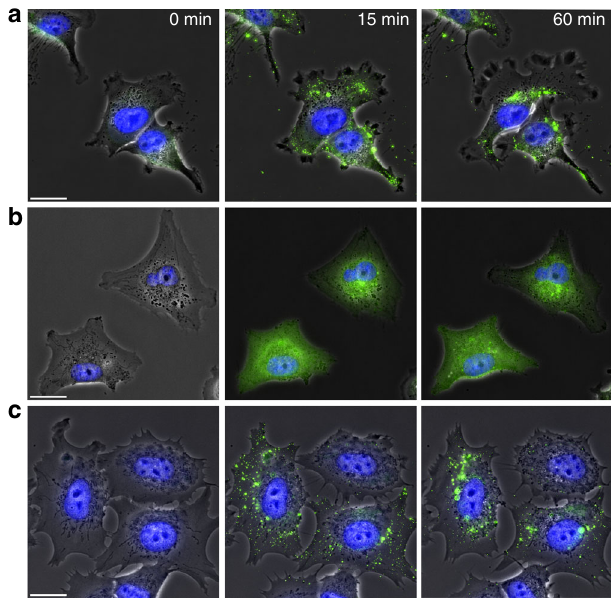
Fig. 4 Dynamics of NP internalization. Extracts of live fl uorescence microscopy images of a and b MDA-MB-231, and c MCF-7 cells exposed to: a and c ANANAS-Atto488-cetux10 (15 µ g/mL, Atto488 = 1.6 × 10 − 7 M) or b cetux-Atto488 (15.1 μ g/mL, Atto4888 1.4 × 10 − 7 M) for 10 min at 37 °C in a fl ow chamber, and then subjected to washing in order to remove unbound nanoparticles. Cells were continuously subjected to low shear fl ow (0.02 dyn/cm 2 ) and imaged for up to 60 min thereafter. The panels display the superimposed images from the Atto488-related signal (green), the phase contrast and nuclei related one (blue, Hoescht). Size bar 20 µ m. Note that during the imaging period the majority of the Atto488-associated nanoparticles move from the cell periphery to the perinuclear region, whereas the majority of the fl uorescent signal associated to cetux-Atto48 remains at the cell surface. The entire live imaging videos from which these representative images were extracted are available in Supplementary Movie 1 and Supplementary Movie 2 (Supplementary Movie 3 is for the non-targeted Formulations; Supplementary Movie 4 and Supplementary Movie 5 show the traf fi cking process of targeted formulation at longer times- between 1 h to 6